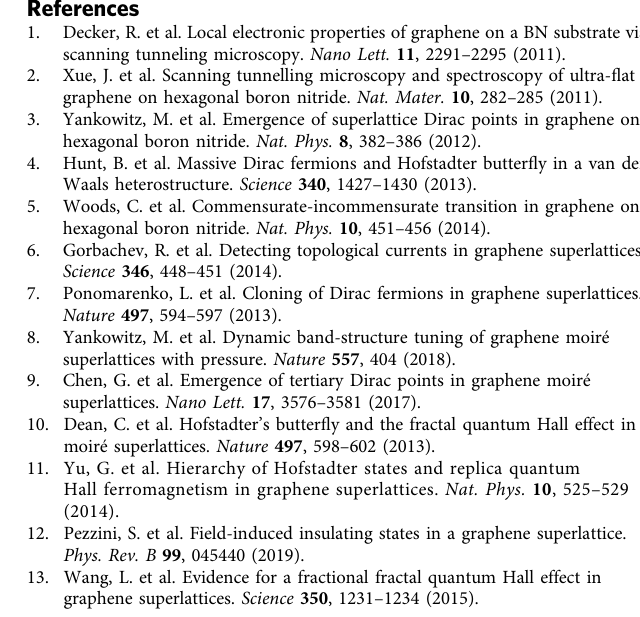
Fig. 4 Effect of trigonal warping on superlattice peaks. Numerically calculated maps of ρ for a γ the experimental results. Some of the characteristic ridges are labeled. With decreasing trigonal warping, ridges B + (B − ) and C + (C − ) merge into a single ridge BC + (BC − ). This indicates that the superlattice peaks are strongly dependent of the shape (or symmetry) of the Fermi